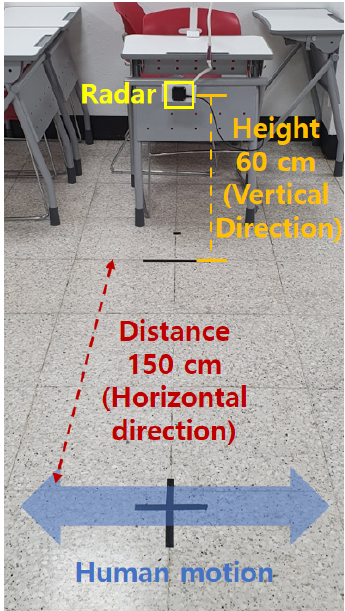
Figure 3. Signal measurement in an indoor